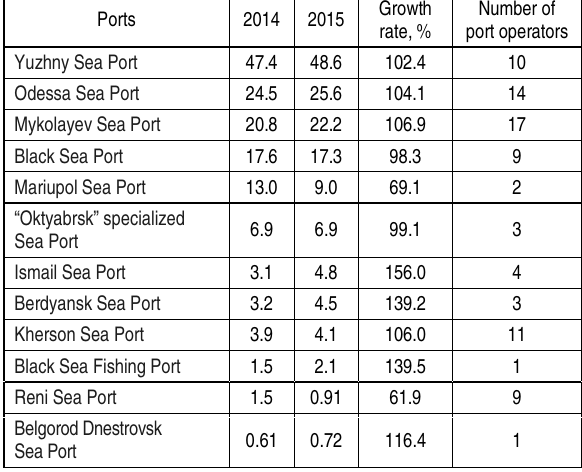
Table 1. Cargo turnover of sea ports (with a volume of more than 100 thousand